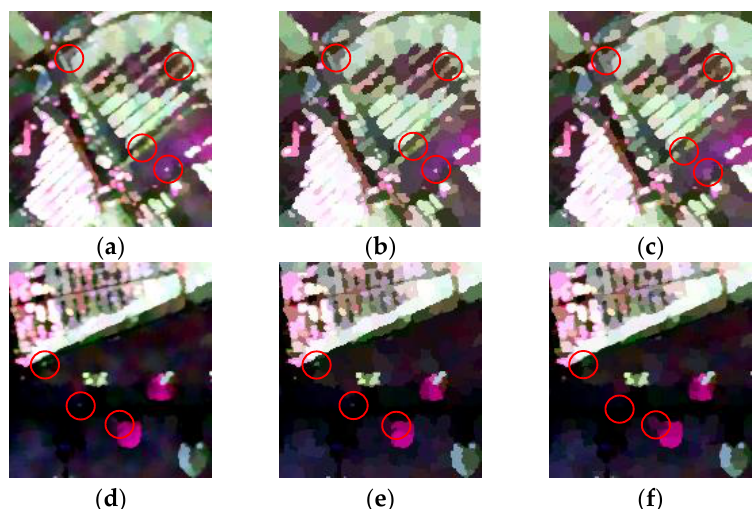
Figure 10. The GMS filtering and segmentation results of the ESAR PolSAR image. ( a ) and ( d ) are the filtering results. ( b ) and ( e ) are the segmentation results with the pre-sorting strategy and the post-processing step. ( c ) and ( f ) are the segmentation results without the pre-sorting strategy and the post-processing step.